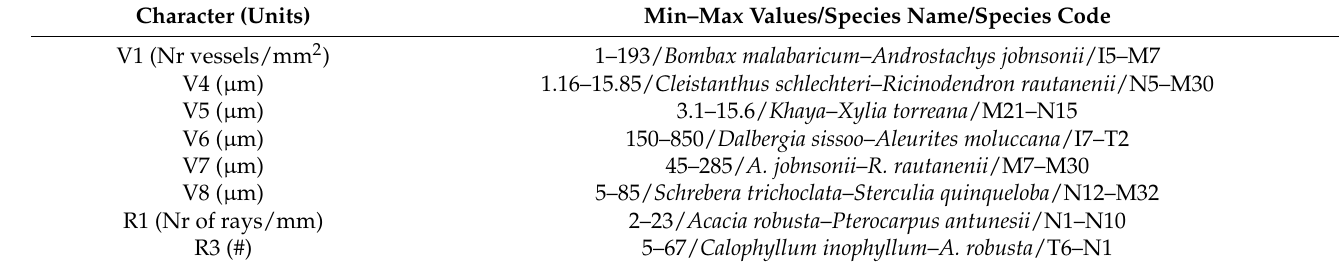
Table 4. Minimum and maximum values found for each of the studied anatomical or physical variables and the scientific names and codes of the corresponding species. For code characters and abbreviations see Table